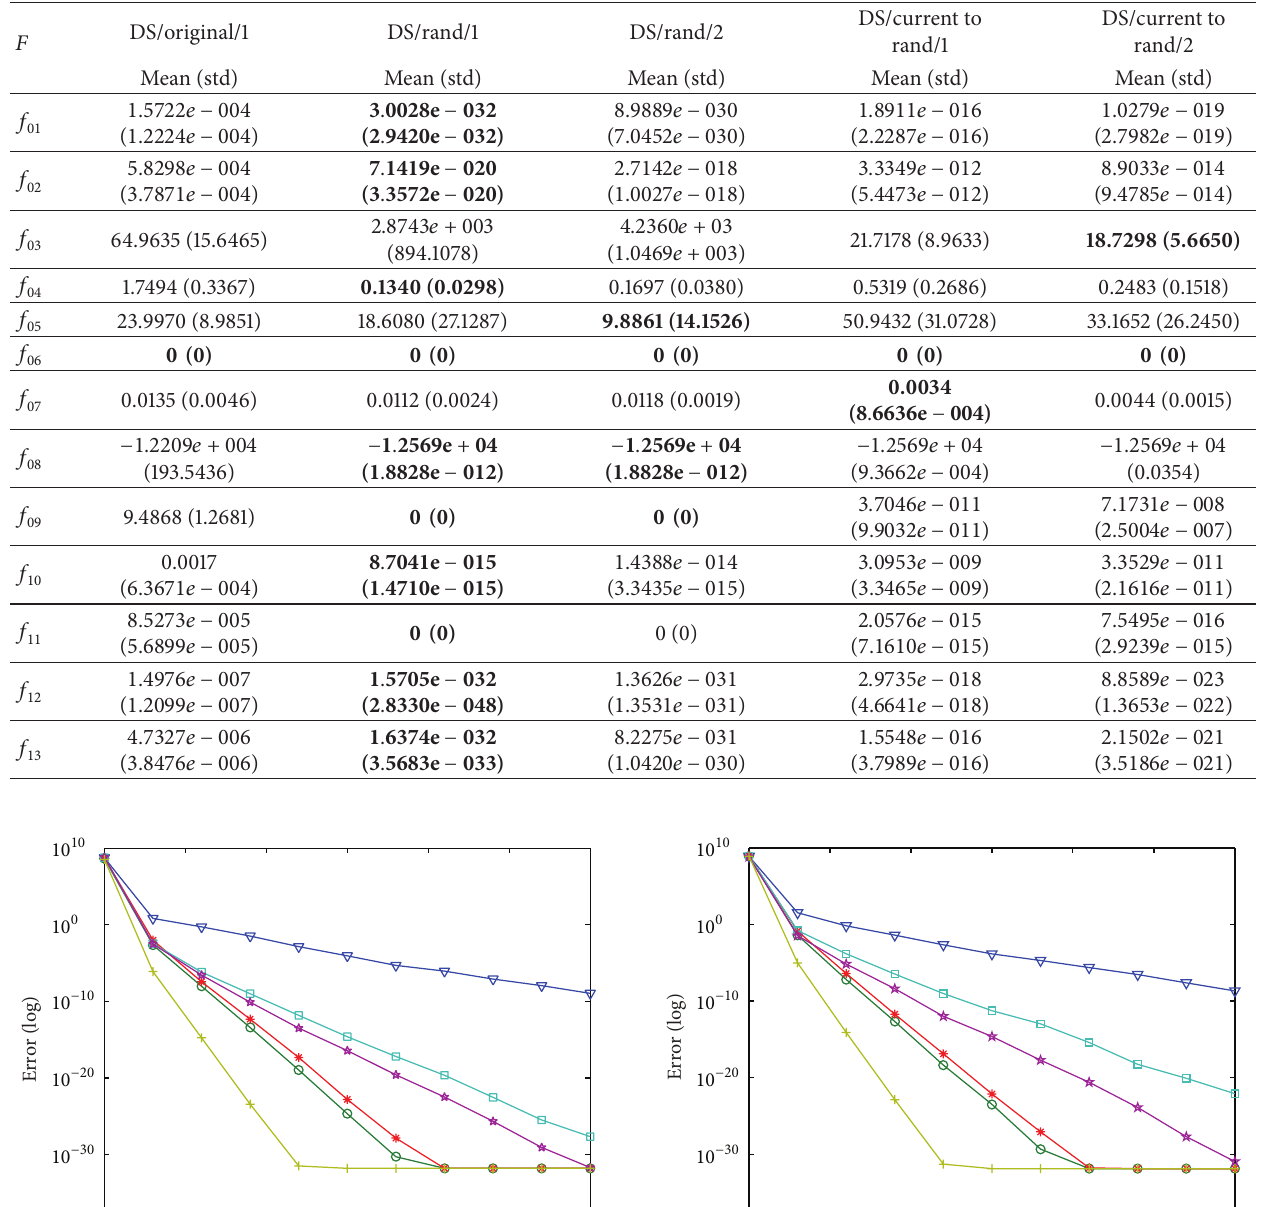
Table 7: Comparisons of different schemes with population size 150.